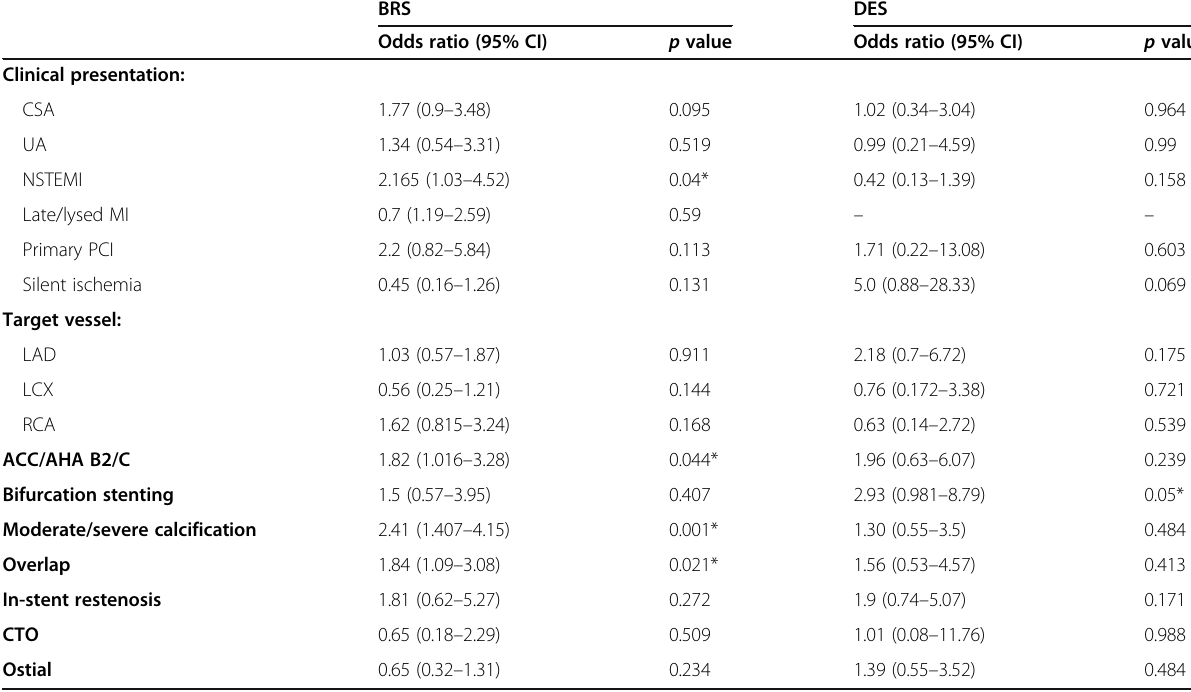
Table 4 Univariate logistic regression analysis of OCT based modification in BRS and